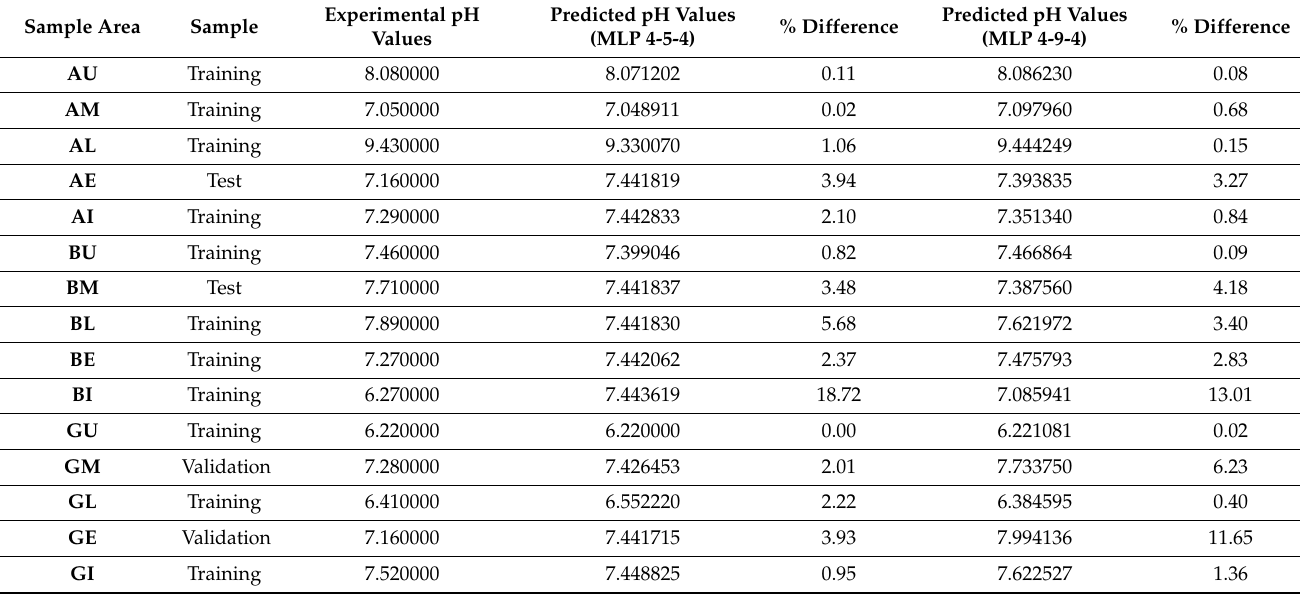
Table 4. Experimental and predicted values for pH generated by MLP 4-5-4 and MLP 4-9-4 networks. Sample: Training, Test, Validation.